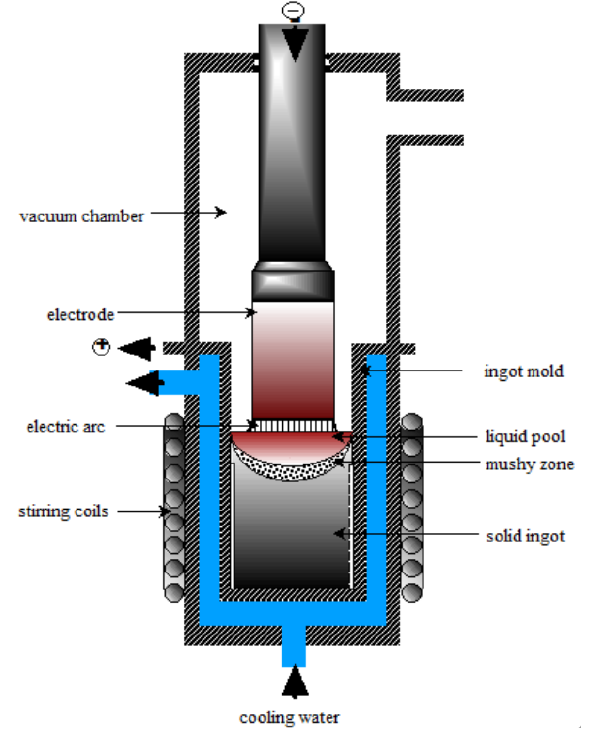
Figure 2. Sketch of the VAR